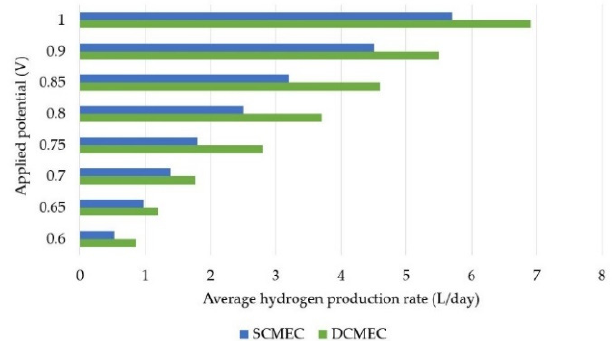
Figure 9. The effect of applied potential on current and hydrogen generation.